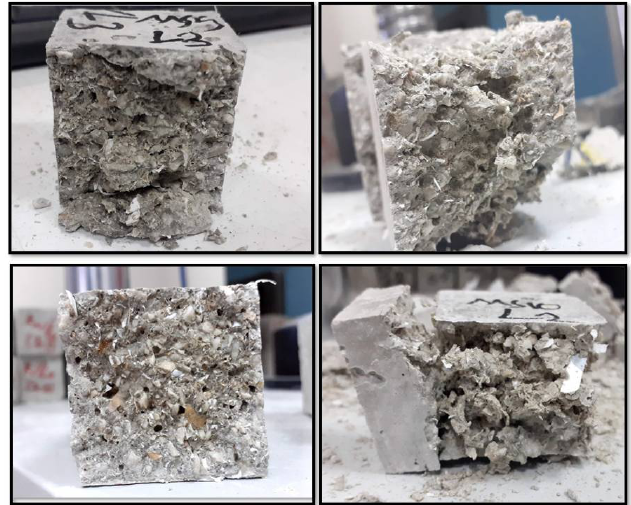
Figure 16. Fiber-reinforced mortar samples after compressive strength test .